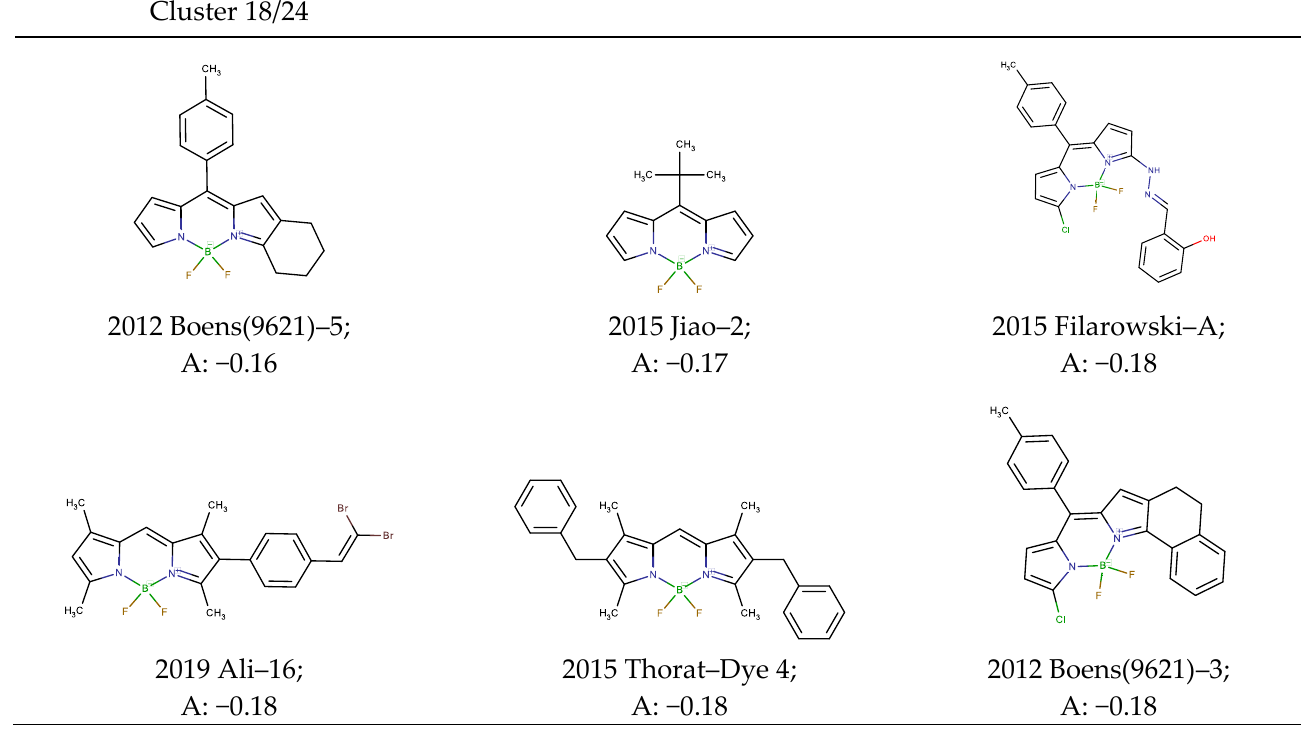
Scheme 9. Chemical structures of the dyes in clusters 18/24 bearing near zero